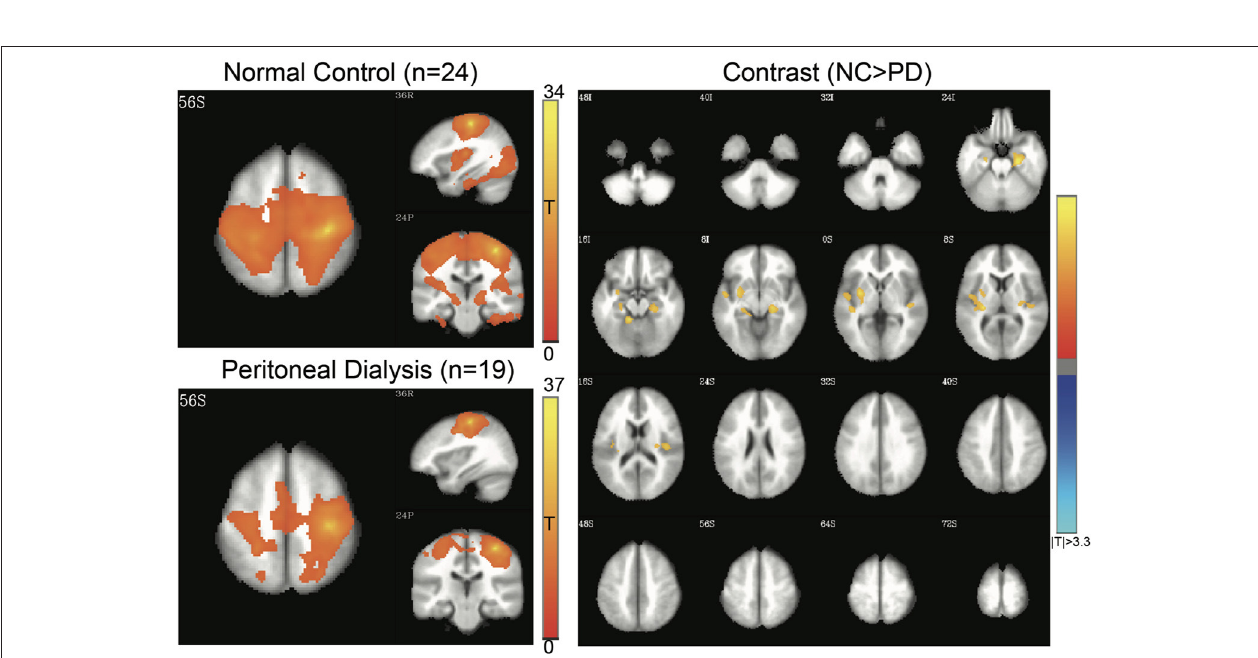
FIGURE 3 | Sensorimotor network (SMN) of controls and patients with PD. Connectivity map of either group is shown at the left side (FWE-corrected p < 0.05), and the contrast map at the right side (3dClustSim-corrected p < 0.05). In the contrast map, the orange color represents significantly increased connectivity in controls, including parahippocampal gyrus and insula. PD, peritoneal dialysis; NC, normal controls.